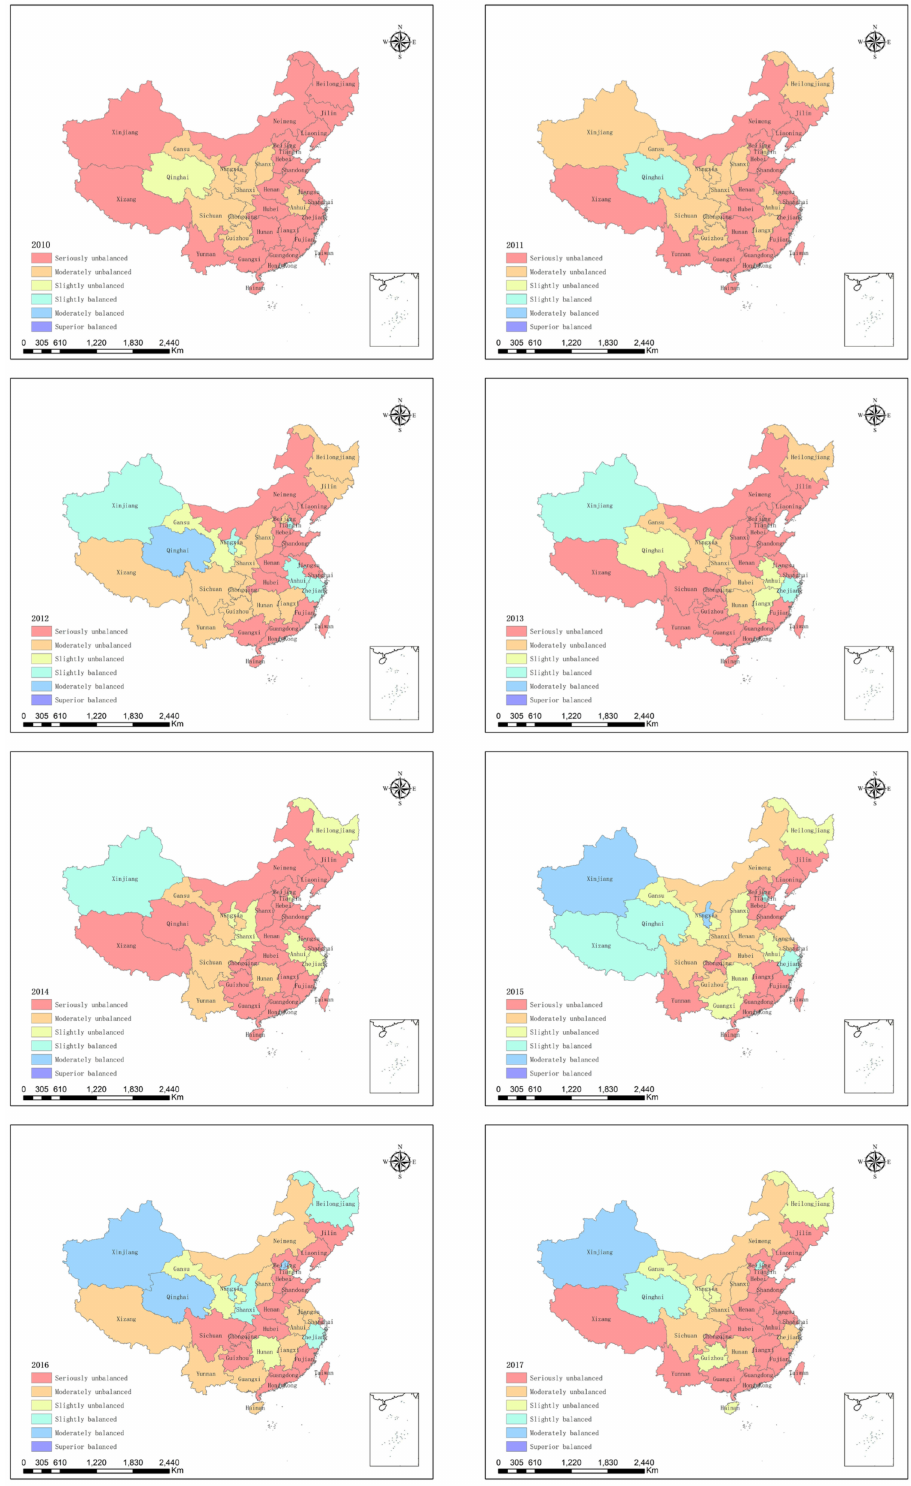
Figure 3. Coordinated development level for population urbanization and affordable housing (from 2010 to